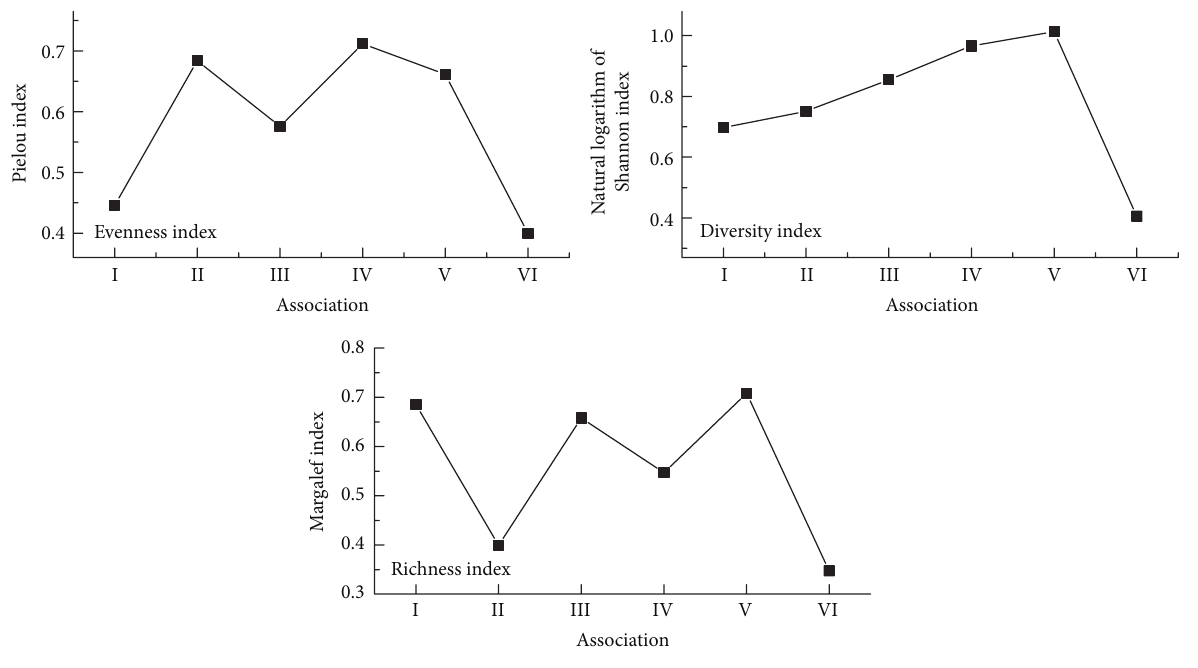
Figure 6: Carex lasiocarpa community biodiversity